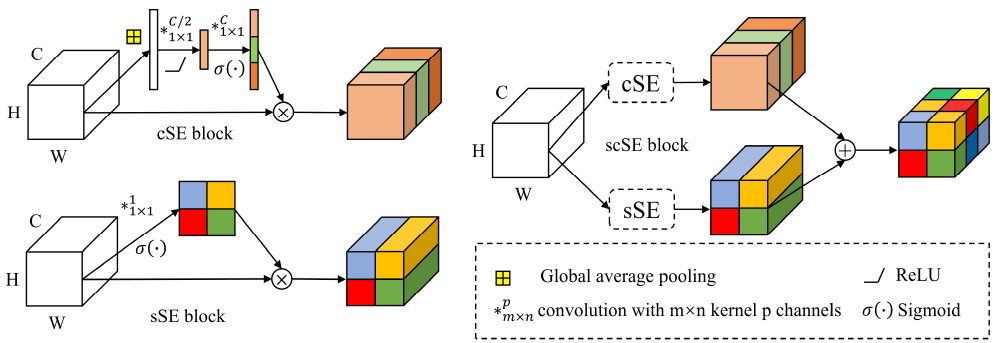
Figure 6. The structure of the scSE block.